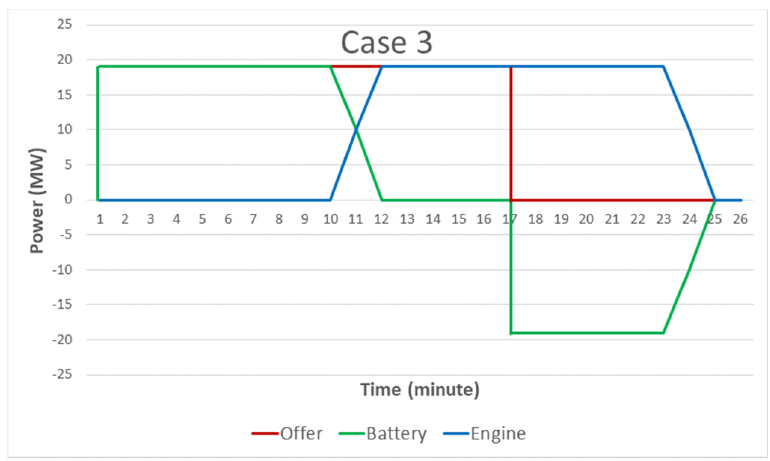
Figure 9. Example operation—case 3.